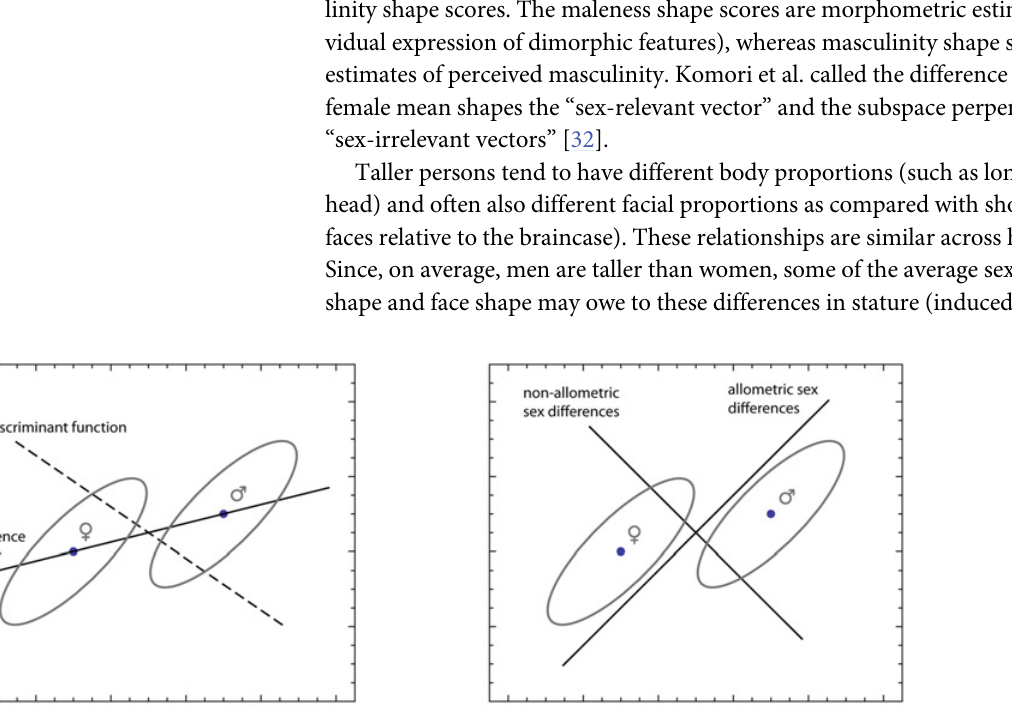
PLOS ONE | DOI:10.1371/journal.pone.0118374 February 11,